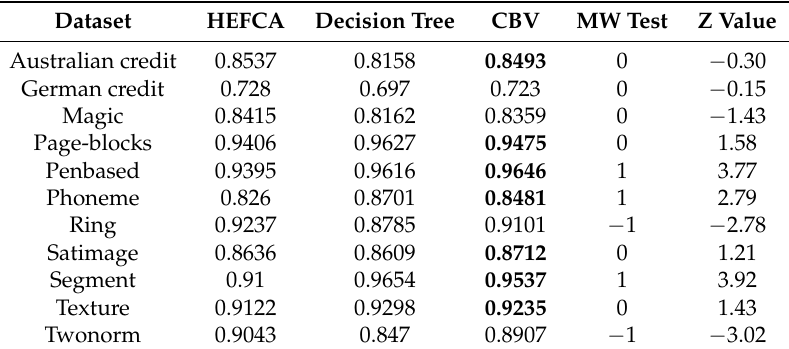
Table 4. Accuracy of HEFCA, Decision Tree and CBV.